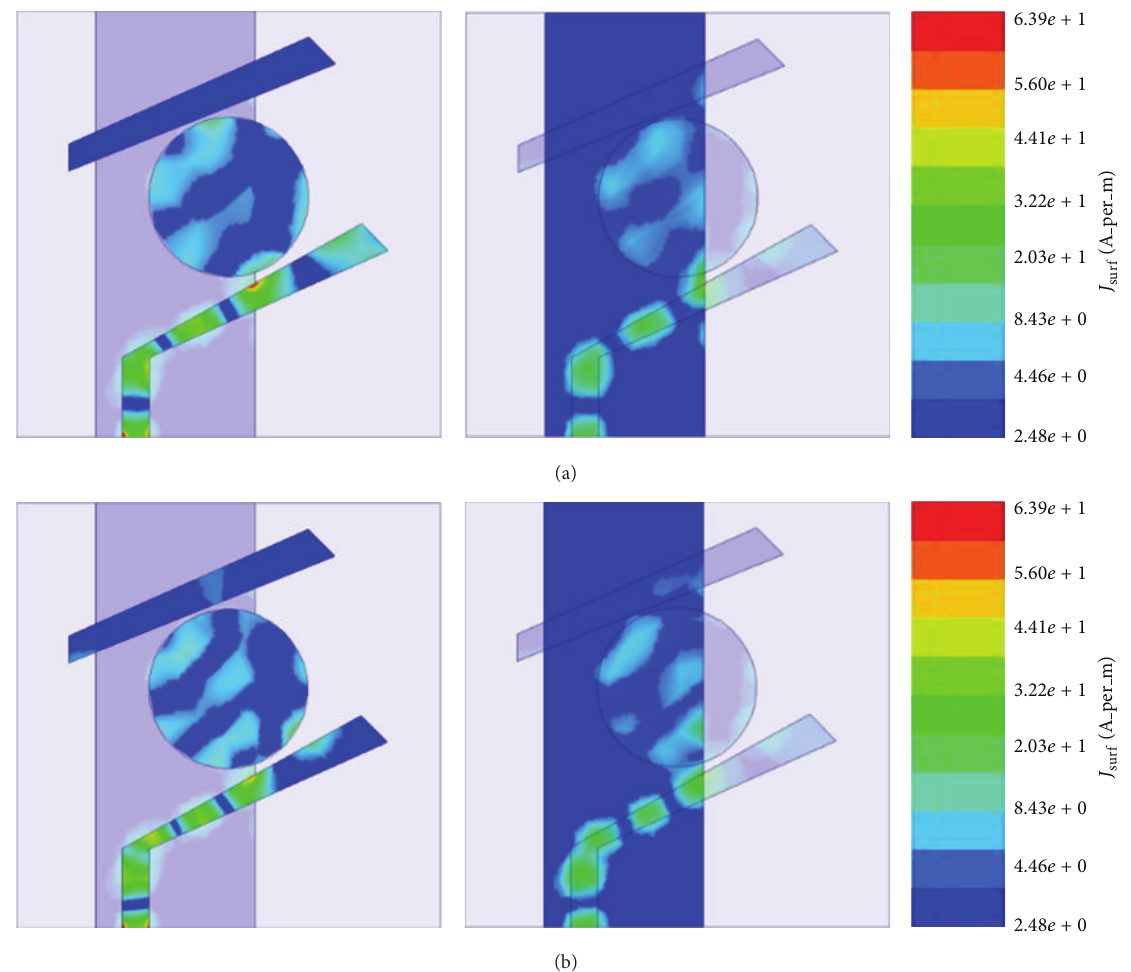
Figure 9: Surface current distribution of patch and ground plane at (a) 5.7 GHz and (b) 7.6GHz in Amp/m.